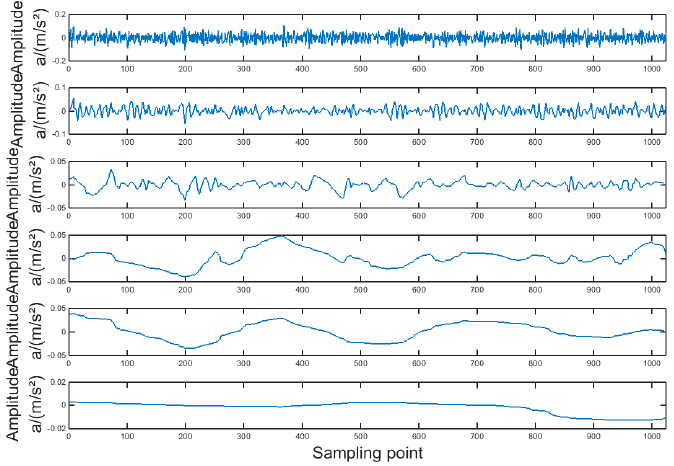
Figure 15. The ITD decomposition results of the vibration signal with the gear pitting fault.